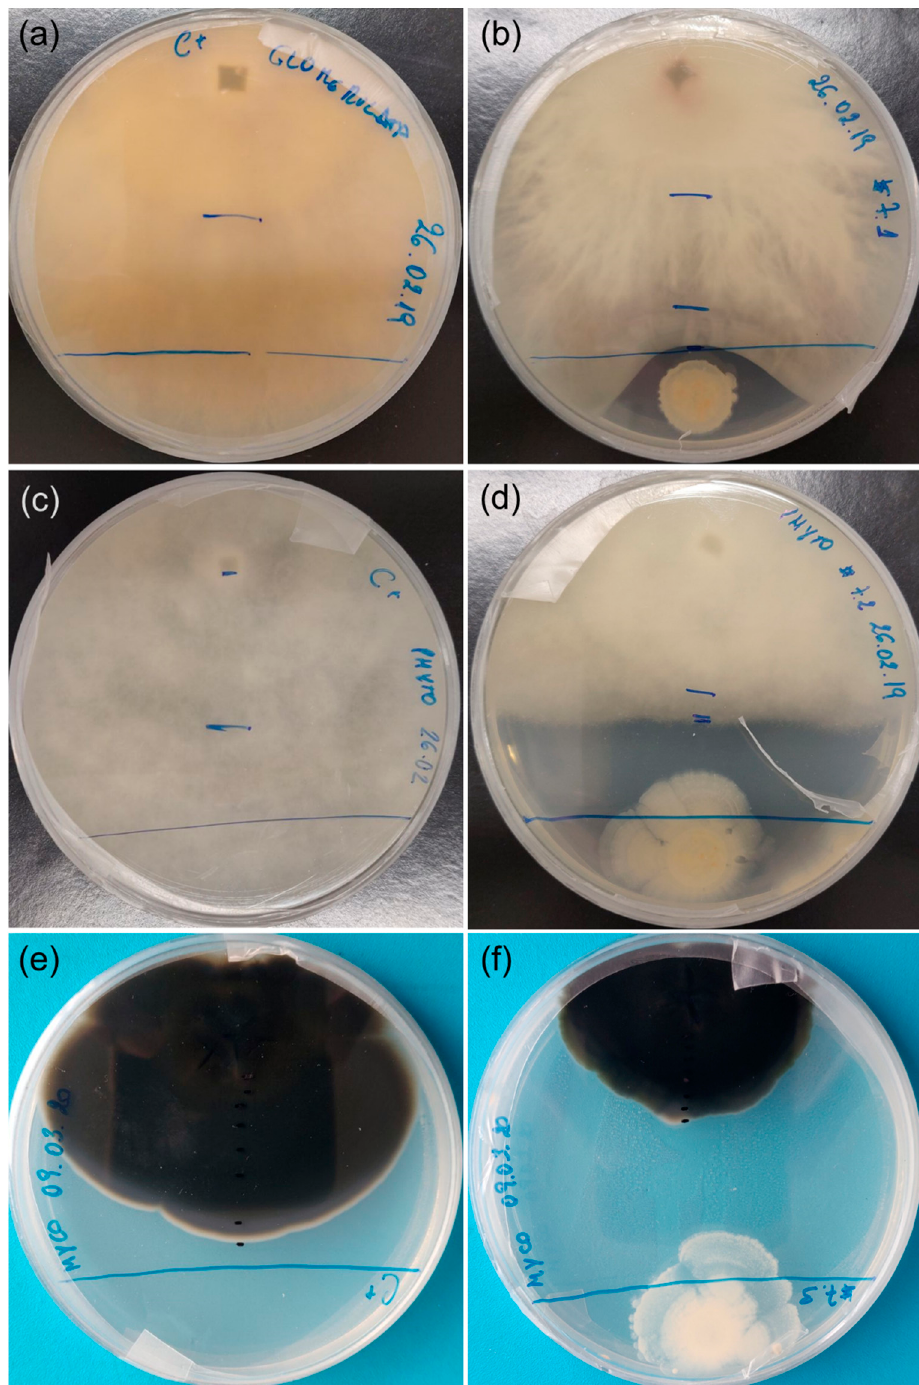
Figure 5. Antagonism test between Bacillus cereus (Au06) and Glomerella cingulata, Phytophthora cinnamomi and Mycosphaerella aurantia. ( a ) G. cingulata (3 weeks); ( b ) G. cingulata and B. cereus (3 weeks); ( c ) P. cinnamomi (3 weeks); ( d ) P. cinnamomi and B. cereus (3 weeks); ( e ) M. aurantia (9 weeks); ( f ) M. aurantia and B. cereus (9 weeks). 2.3. Plant Growth-Promoting Potential of Endophytic Bacteria Isolated from Strawberry Tree From the 16 isolates tested, five were found to produce siderophores: Au01 ( P. avellanae ), Au06 ( B. cereus ), Au14 ( B. safensis ), Au39 ( P. poae ) and Au43 ( S. panni ); and four were able to solubilize phosphate: Au04 ( B. megaterium ), Au32 ( P. marchantiophytorum ), Au39 ( P. poae ) and Au61 ( Bacillus taxi ) (Table 2). Whereas most of the isolates tested were